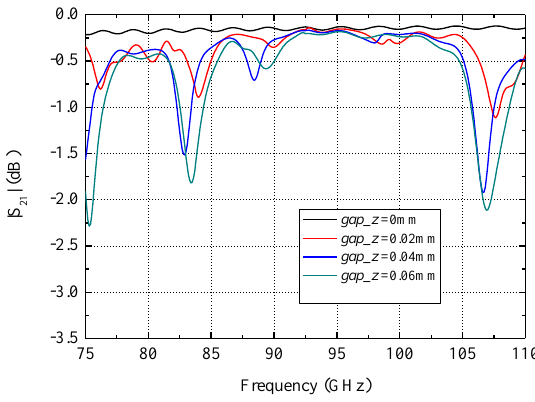
Figure 5. Simulation results of variation in different length of air gaps ( gap_z ).